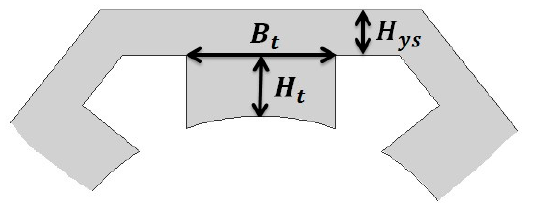
Figure 4. Dimension of heptagonal stator of the heptagonal based WRSM.